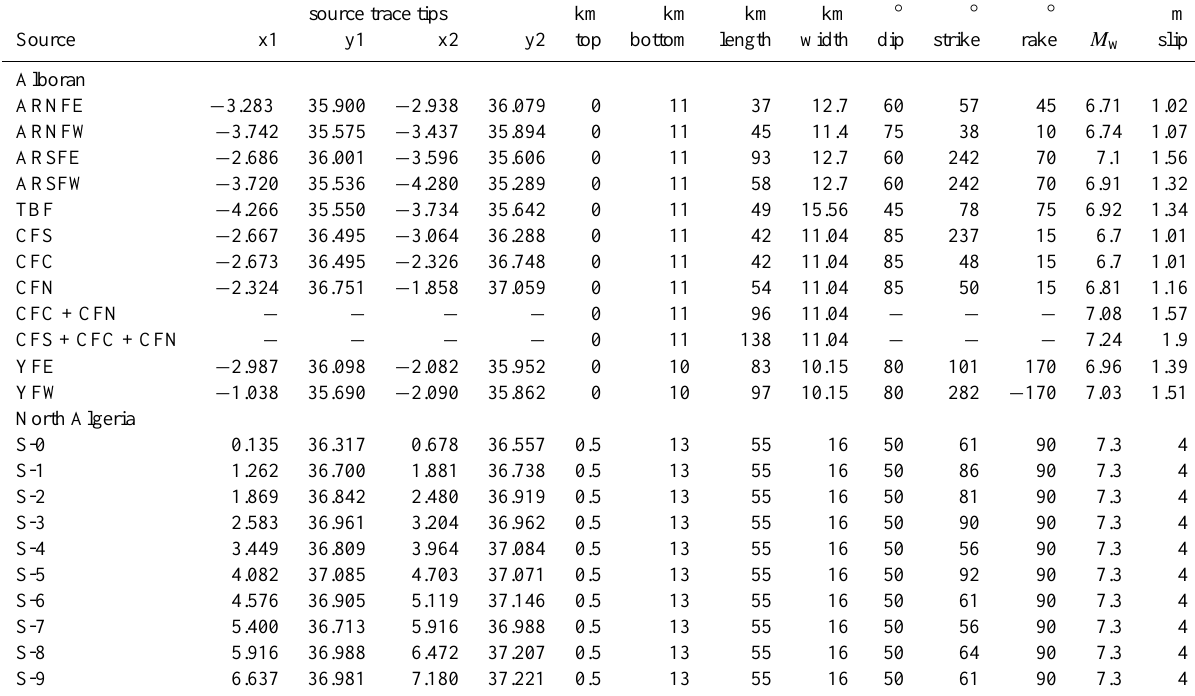
Table 1. Parameters of the considered tsunamigenic seismic sources from ´Alvarez-G´omez et al. (2010a,b). source trace tips km km